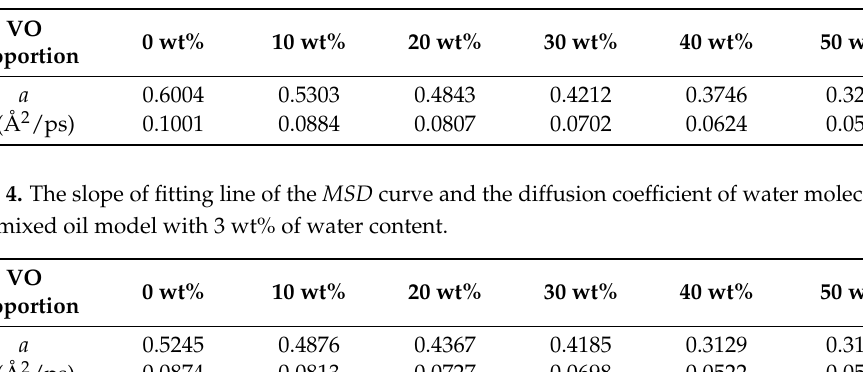
Table 3. The slope of fitting line of the MSD curve and the diffusion coefficient of water molecules in each mixed oil model with 2 wt% of water content.